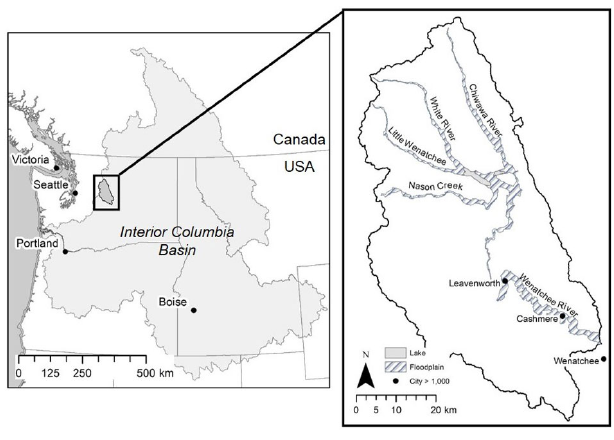
Fig. 5 . The Wenatchee system floodplain situated in central Washington